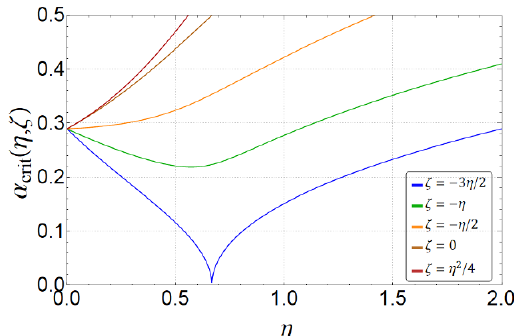
Figure 10. This plot demarcates the critical value of (cid:11) above which the theory becomes unstable, as a function of (cid:17) and for di(cid:11)erent values of (cid:16) .